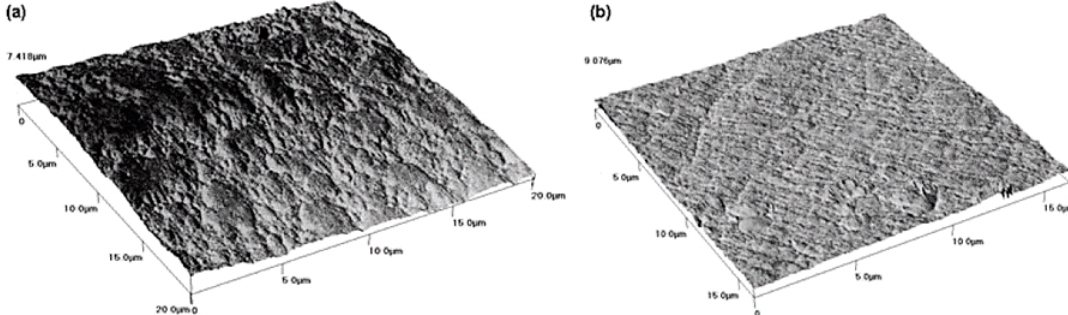
Figure 1. AFM images of Ni electrodeposited on Cu substrate from IL–Ni containing 0.5 M NiCl 2